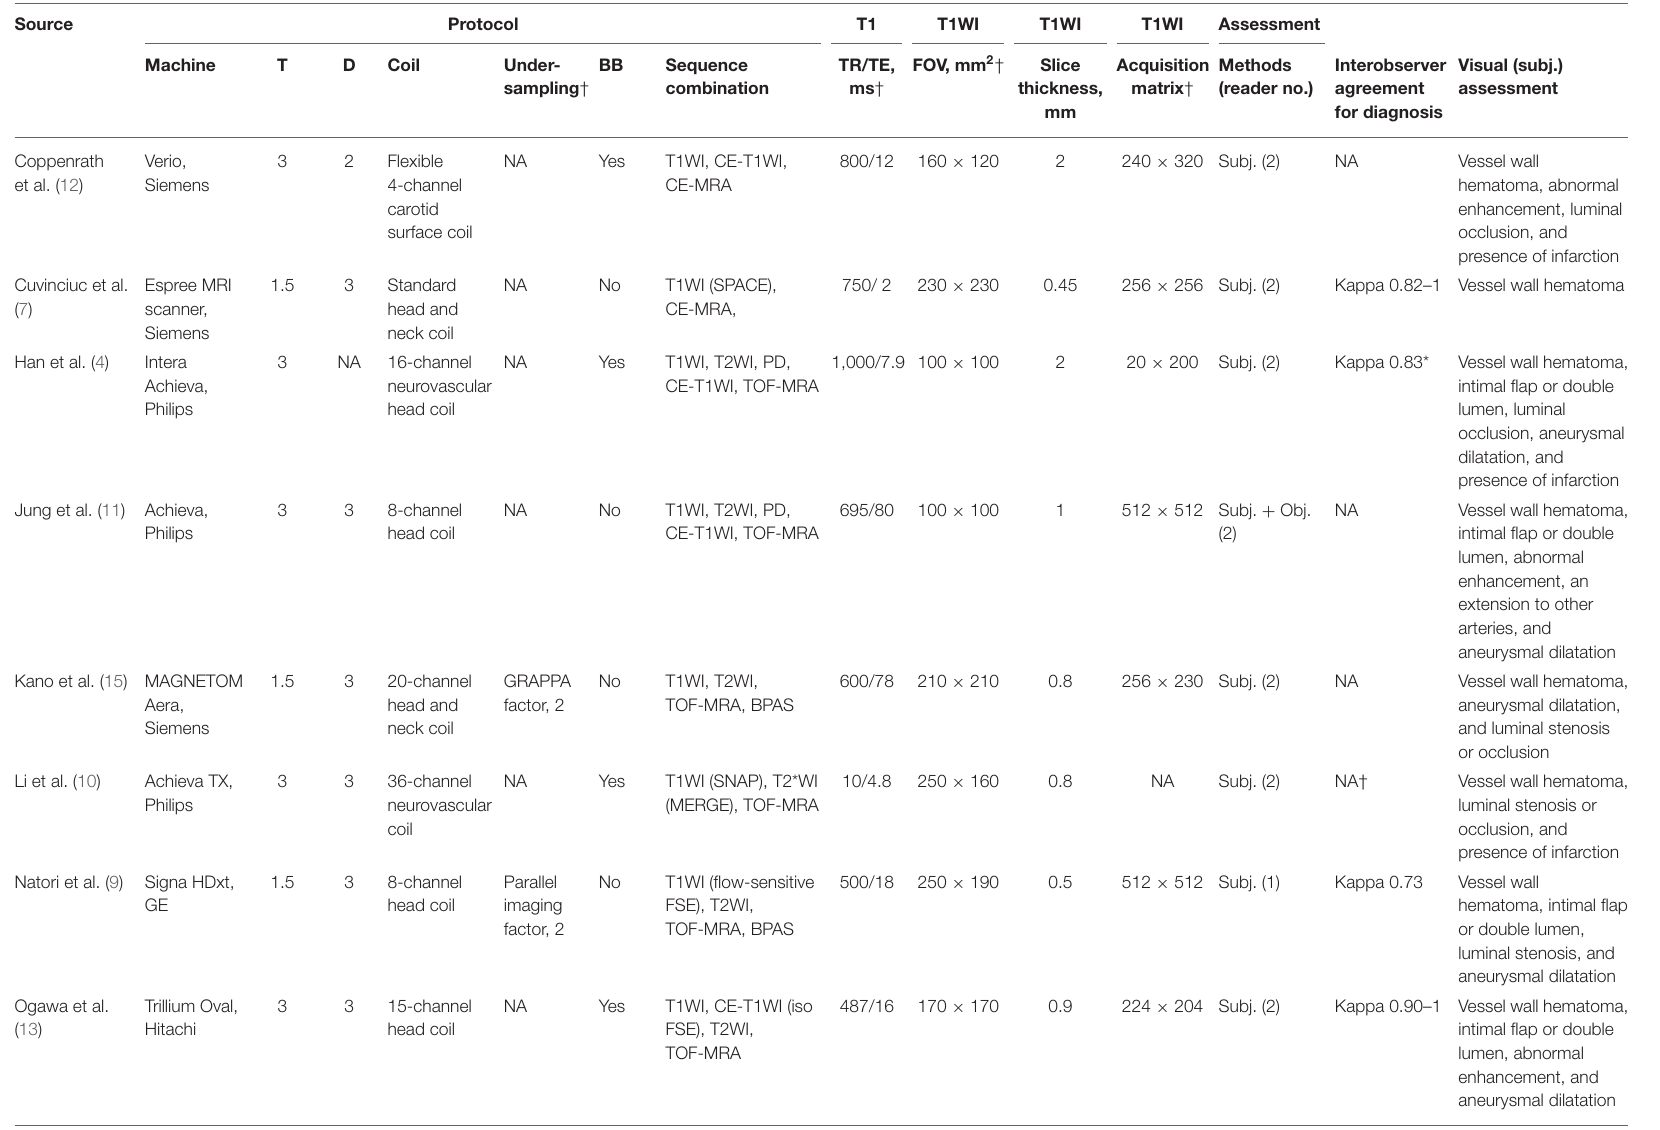
TABLE 3 | Characteristics of magnetic resonance vessel wall